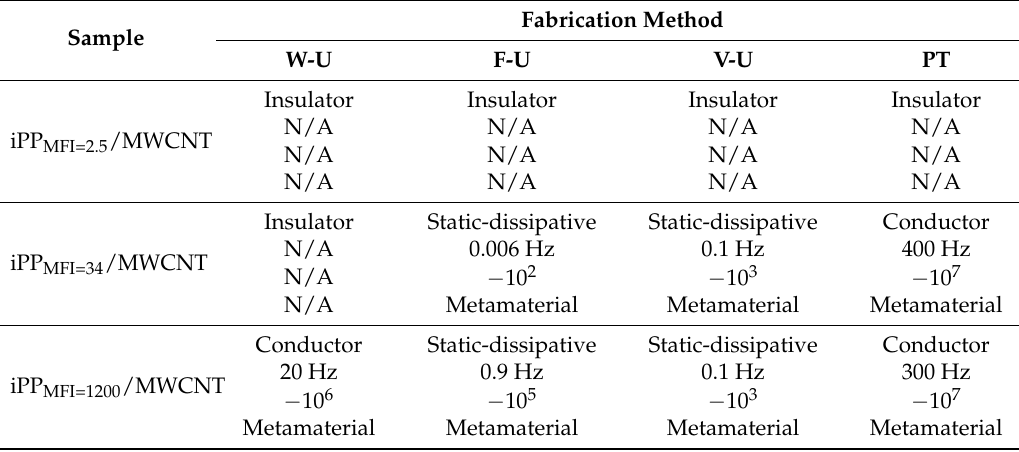
Table 1. Reading from top to bottom: type of electrical material 1 , crossover frequency from negative to positive ( ω p ), negative ε (cid:48) maximum value, and metamaterial classification for iPP/MWCNT nanocomposites fabricated by different ultrasound-assisted